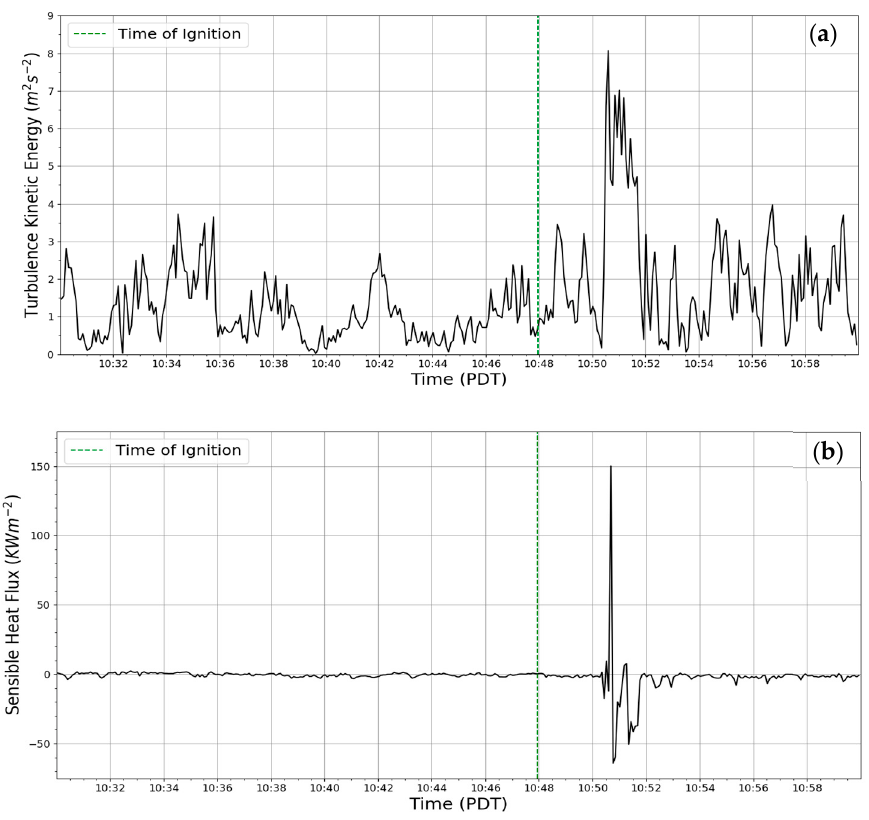
Figure 11. Time series of 10-s averaged ( a ) turbulence kinetic energy and ( b ) sensible heat flux. The vertical dashed line indicates the time of ignition.